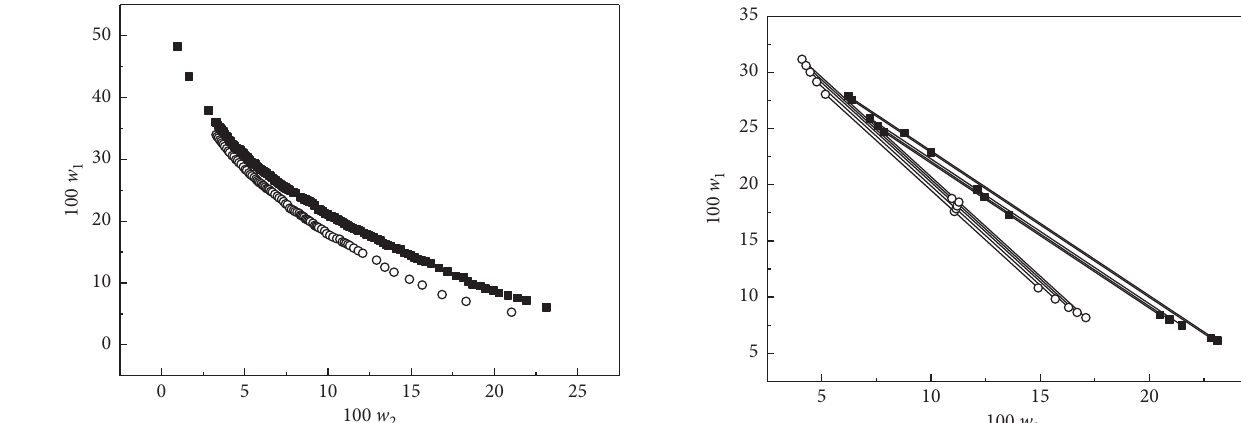
Figure 5: Effect of salt on the tie-line system concerning isopropyl alcohol +ethanol +Na 2 SO 4 /Na 2 CO 3 +water ATPSs at T � 308.15 K; ■ Na 2 SO 4 ; ○ Na 2 CO 3